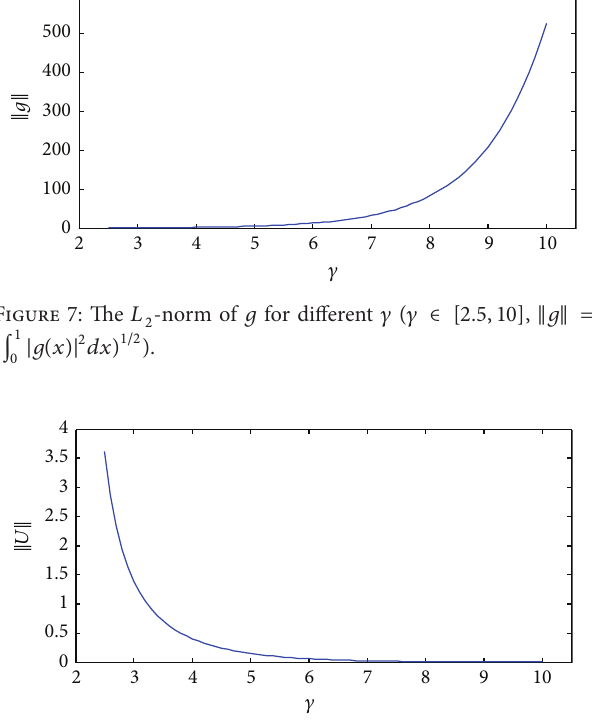
Figure 4: The shape function 𝑔(𝑥) ( 𝛾 = 4.5 ).